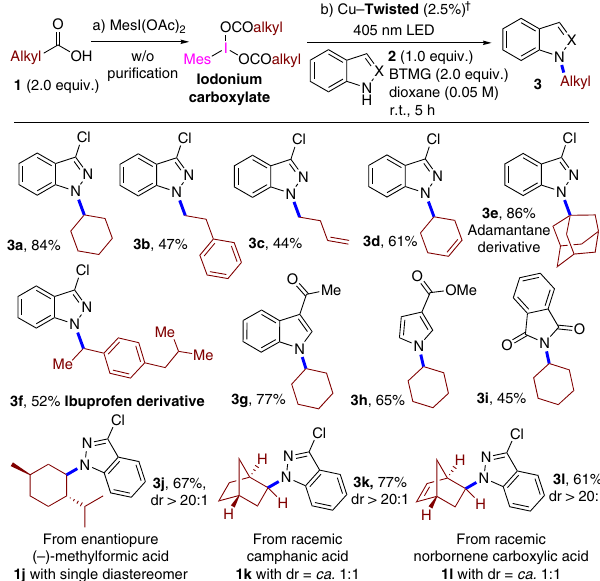
Fig. 4 Decarboxylative C(sp 3 ) – N coupling by Cu – Twisted. † Conditions: iodonium carboxylate prepared from 1 (2.0 equiv.), N -nucleophile 2 (0.3 mmol, 1.0 equiv.), Cu – Twisted (2.5%), BTMG (2.0 equiv.), dioxane (0.05 M), 405 nm LED, N 2 , room temperature (r.t.), 5 h. Isolated